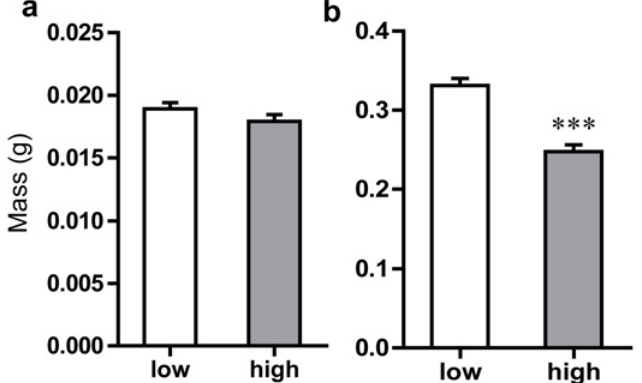
Fig 1. Effect of Betula pendula leaf surface lipophilic compounds on Lymantria dispar larval weight. The weight (mean ± SE) of young (a) and middle (b) instar larvae reared on leaves with low and high concentrations of surface lipophilic compounds is presented. The data were compared using a one-way ANOVA. Asterisk means the significant differences between bars (at P <